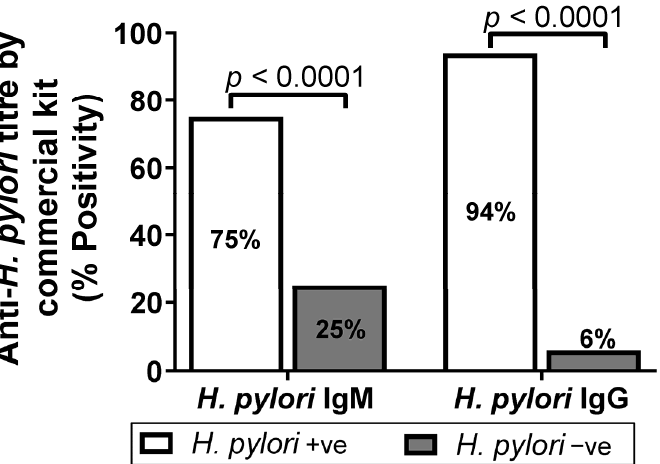
Figure 3. Graph showing comparison of H. pylori IgG and IgM titer between different H. pylori positive percentages of gastroduodenal ulcer and gastritis patients using commercial kit ELISA.